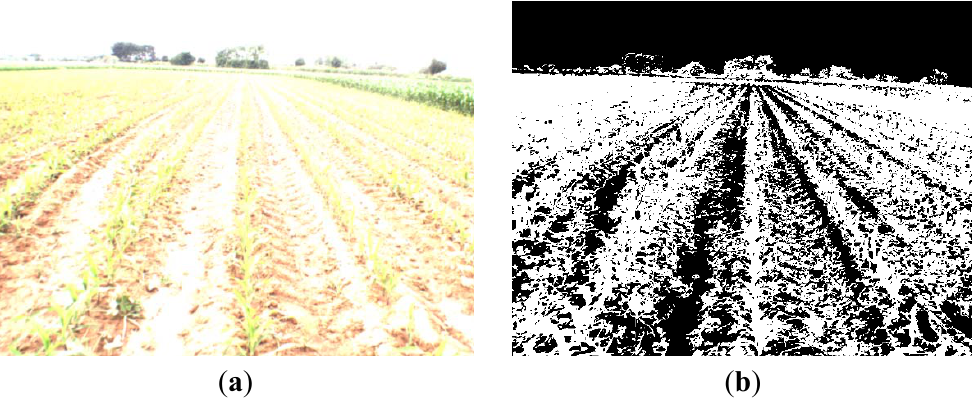
Figure 12. ( a ) Original saturated image; ( b ) binary image after segmentation.